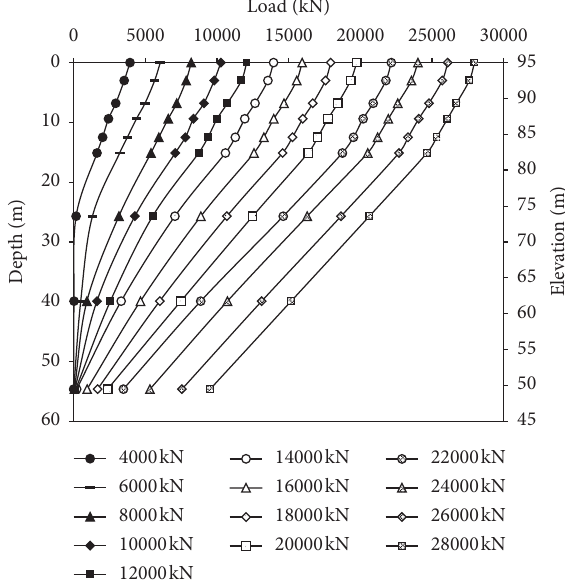
Figure 12: Load transfer mechanism of P12.